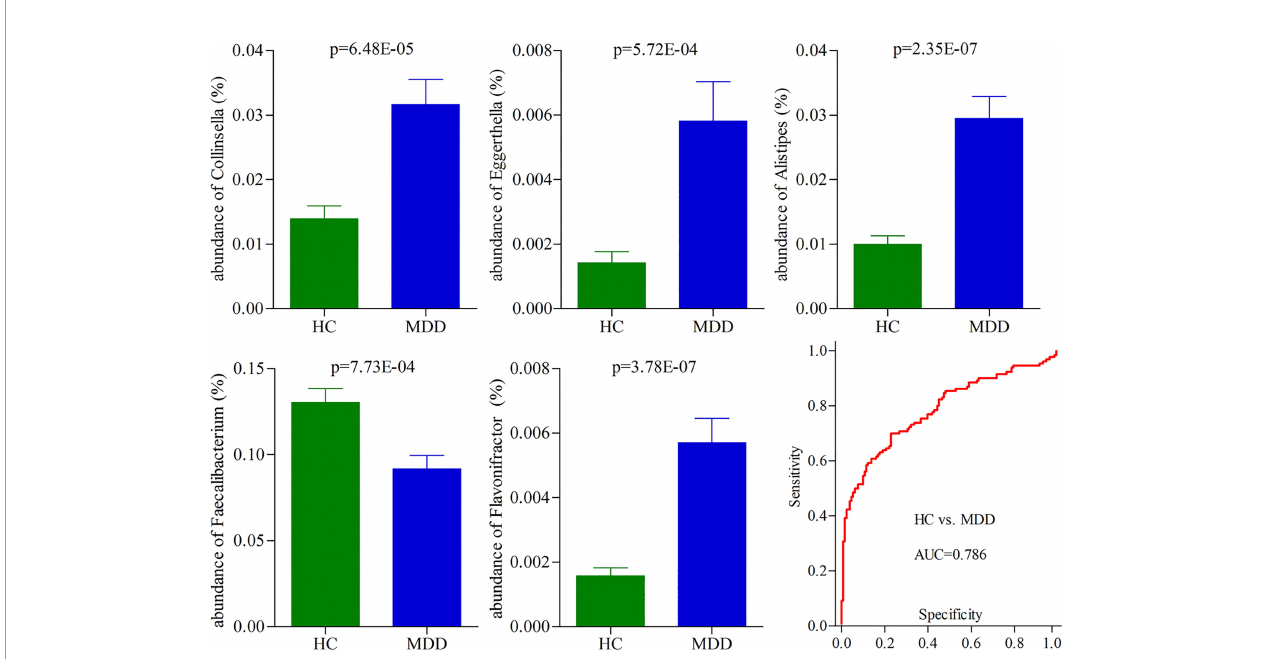
FIGURE 3 | Five differential genera as potential biomarkers for diagnosing MDD. The model consisting of these fi ve genera had the minimum AIC value; thus, they were viewed as the potential biomarkers. The panel consisting of these fi ve genera could yield an AUC of 0.786 for classifying MDD patients from HC, suggesting fair diagnostic performance in diagnosing MDD. HC, healthy controls; MDD, major depressive disorder; AUC, area under the curve.